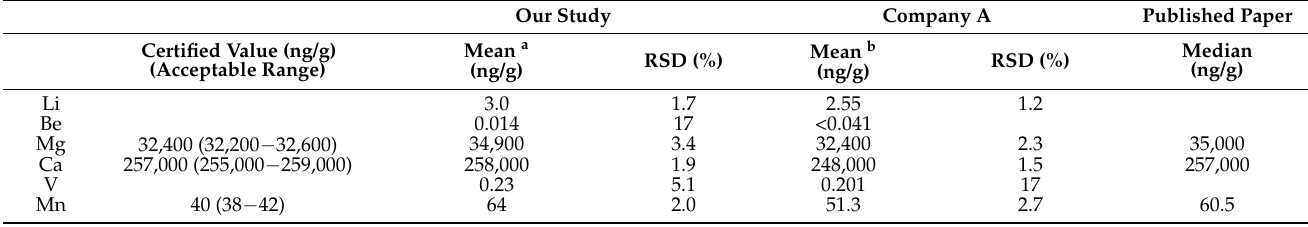
Table 3. Analysis results for National Institute of Standards and Technology standard reference material (1953) in our laboratory, another institution, and published